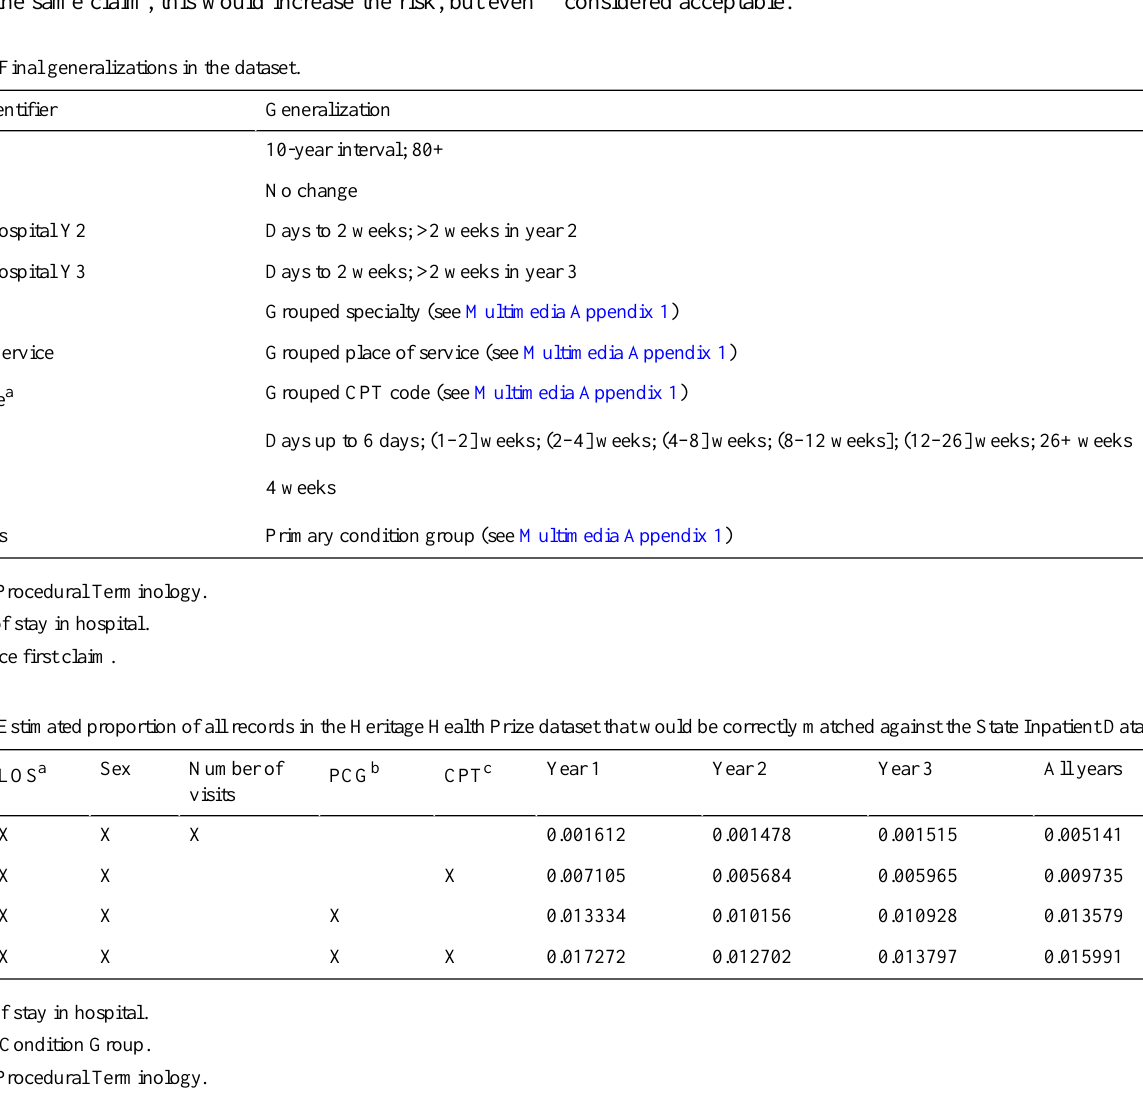
Table 7. Percentage of total records correctly matched under simulated attack with different assumptions about the number of claims (power).